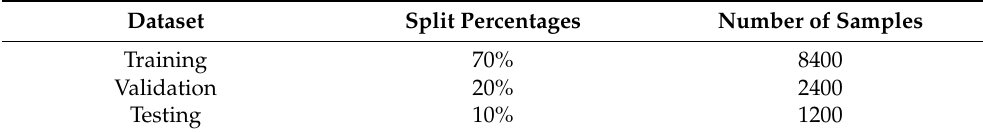
Table 2. Split of alphanumeric-based data